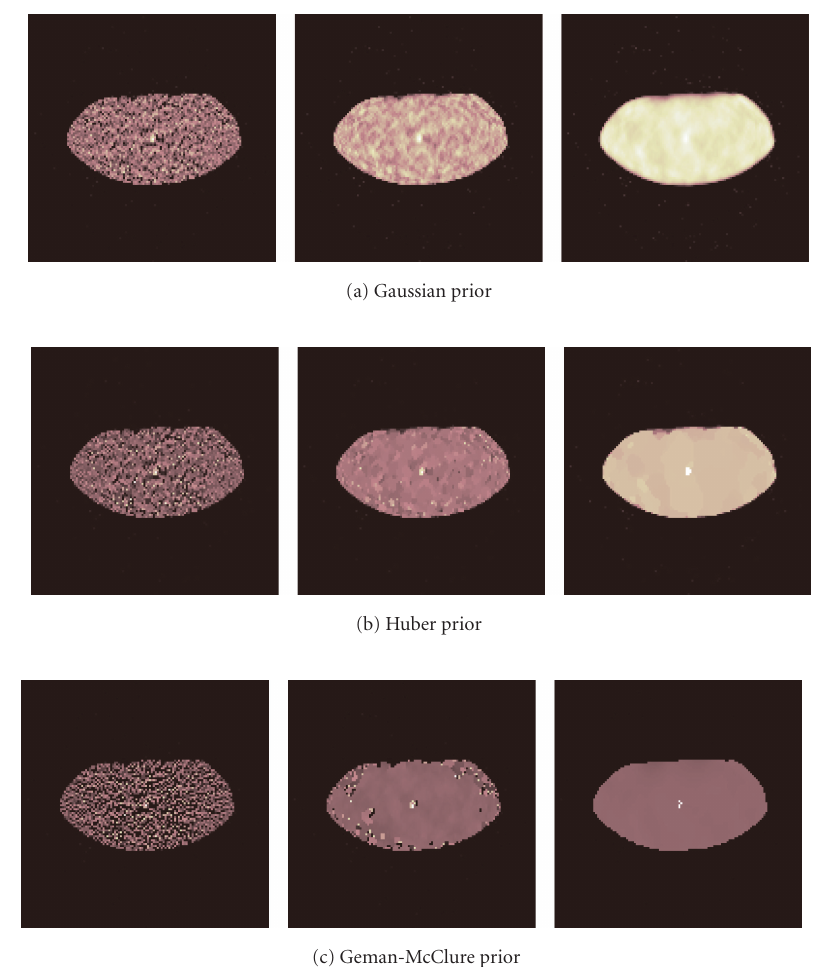
Figure 4: Reconstructed images of one noisy data set with a fixed background. The three images in each group are reconstructed with di ff erent β